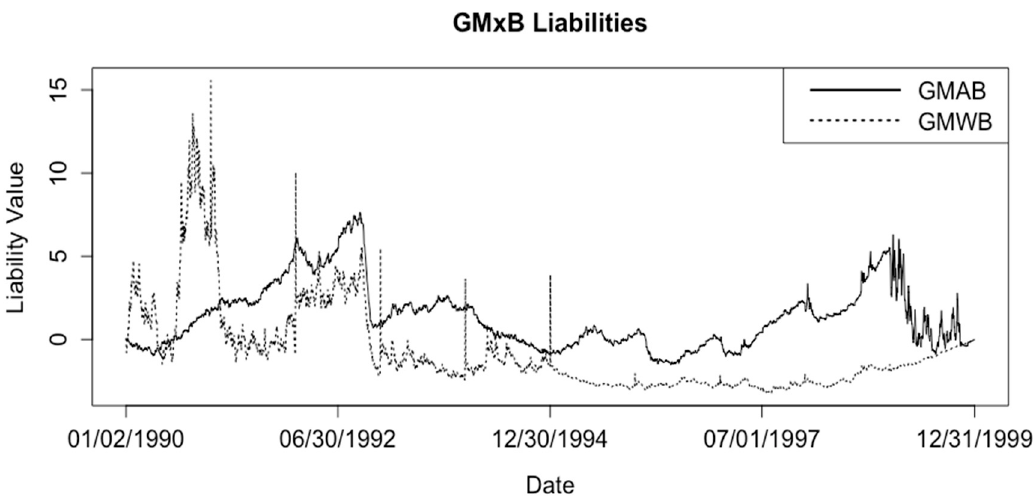
Figure 2. Liability values of two of the four GMxB guarantees over the period 1990–1999.